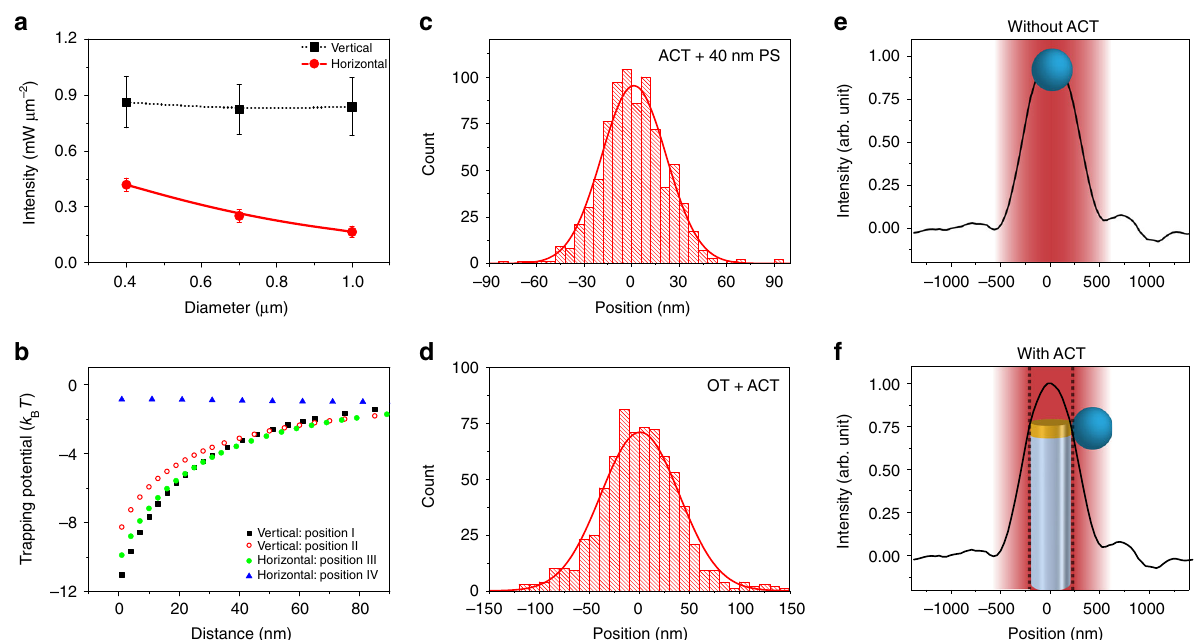
Fig. 5 Analysis of ACT performance. a Minimum illumination intensity to trap beads (Spherotech Inc.) as a function of the bead size for two con fi gurations of the ACT. b Calculated plasmonic trapping potential for a 100 nm PS particle as a function of distance from the nanodisk. The simulations were performed in the two con fi gurations, for positions of the PS particles as marked in Fig. 4c, d. c Histogram of position fl uctuations of a 40 nm PS particle trapped on a static ACT. d Histogram of position fl uctuations of a trapped ACT in an optical tweezer (OT) in vertical con fi guration. e , f Measured intensity pro fi le of the focused gaussian beam shown in black lines. Schematic shows position of the trapped bead without and with the ACT within the optical trap: peak illumination intensity is blocked the ACT, implying trapped colloids are in a relatively lower intensity region of the Gaussian beam